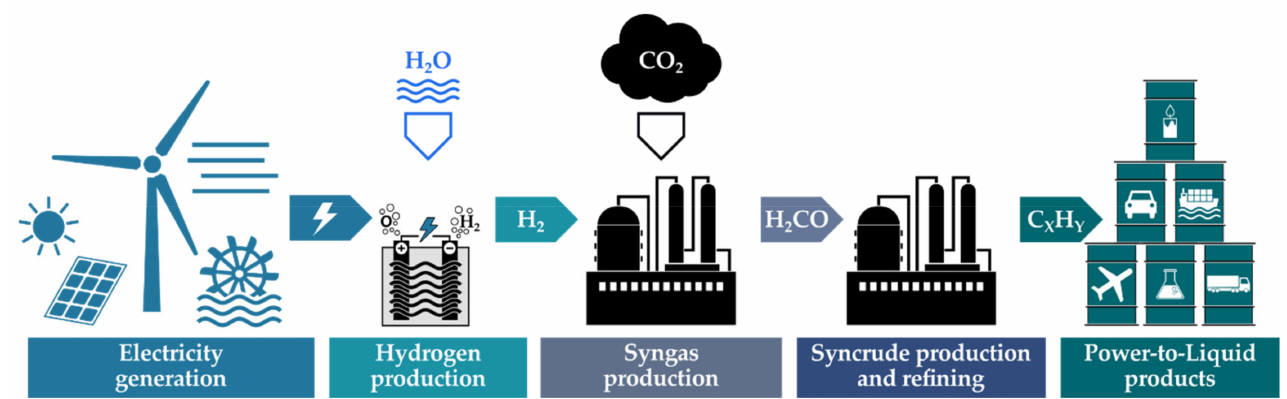
Figure 1. Generic scheme of a power-to-liquid